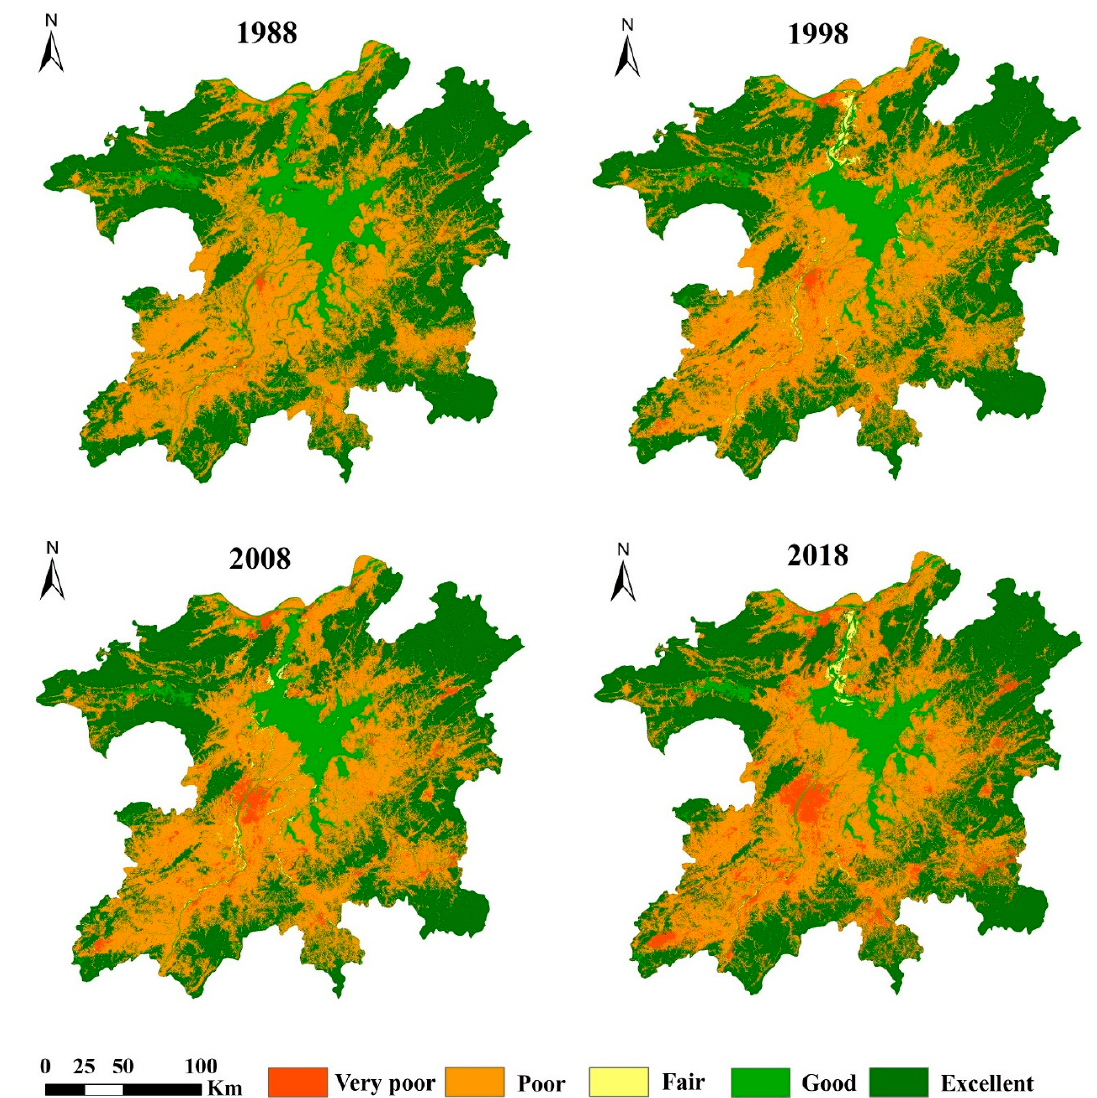
Figure 9. The spatial distribution of the habitat quality levels in the PLEEZ from 1988–2018.